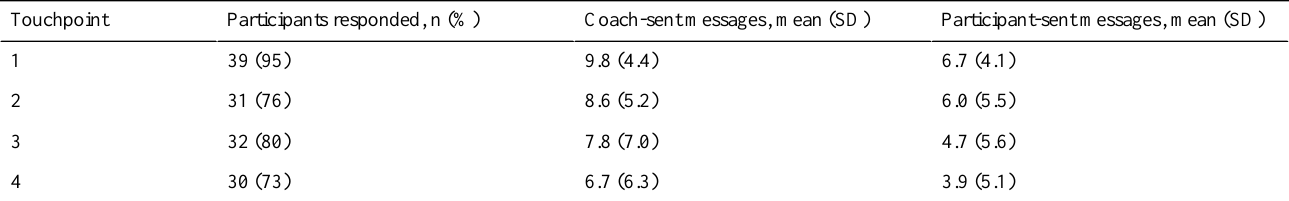
Table 2. Engagement with human coaching via digital text messaging interface.